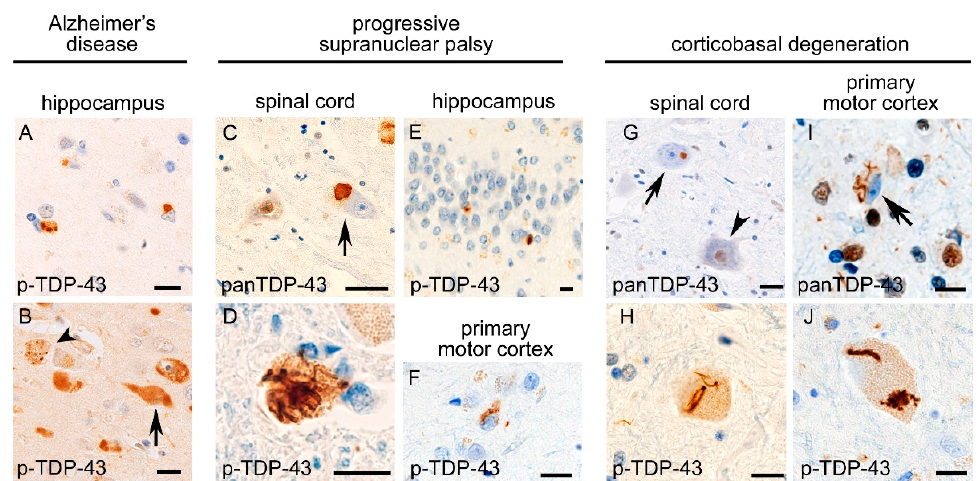
Figure 3. Comorbid TDP-43 pathology in tauopathies. TDP-43 aggregates of Alzheimer’s disease patients are observed prominently in the limbic system, of which morphological characteristics and distributions are similar to those of LATE ( A ). Anti-phosphorylated TDP-43 immunohistochemistry also shows NFT-like aggregates ( B , arrow) and recognizes granulovacuolar degeneration ( B , arrowhead). In progressive supranuclear palsy, the spinal cord motor neuron demonstrates cytoplasmic aggregates and nuclear mislocalization of TDP-43 ( C , arrow, and D ). TDP-43 pathology is also observed in the hippocampal granule cells ( E ) and primary motor cortex ( F ) [80]. In corticobasal degeneration, spinal cord motor neuron ( G , arrow, and H ) and small pyramidal neuron and Betz cell in the primary motor cortex ( I,J ) show TDP-43 pathology. ( A , B , D – F , H , J ) Anti-phosphorylated TDP-43 and ( C , G , I ) anti-panTDP-43 immunohistochemistry. ( A ) amygdala, ( B ) hippocampus. Bars: 10 μ m.